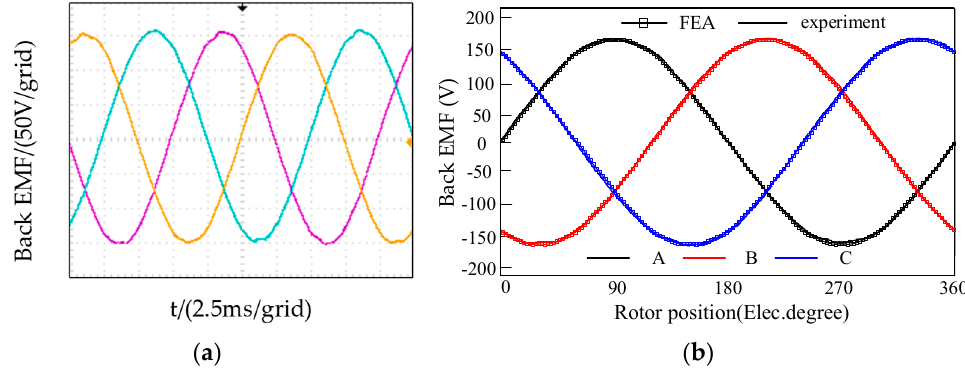
Figure 18. Waveforms of back-EMF at no load: ( a ) measured waveform and ( b ) comparison of finite element simulation and experimental waveforms of A, B, C three phases of the back-EMF.